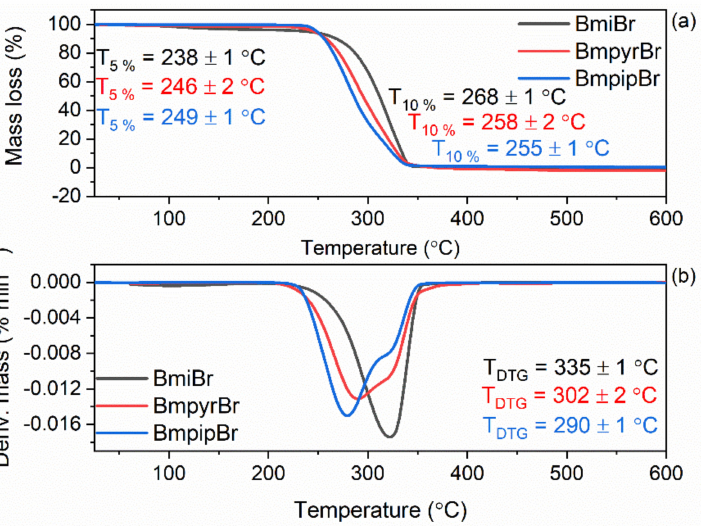
Figure 3. Thermal stability of BmiBr, BmpyrBr, and BmpipBr: ( a ) TG curves; ( b ) DTG curves. Investigated ILs completely decomposed in the temperature range of 25–400 ◦